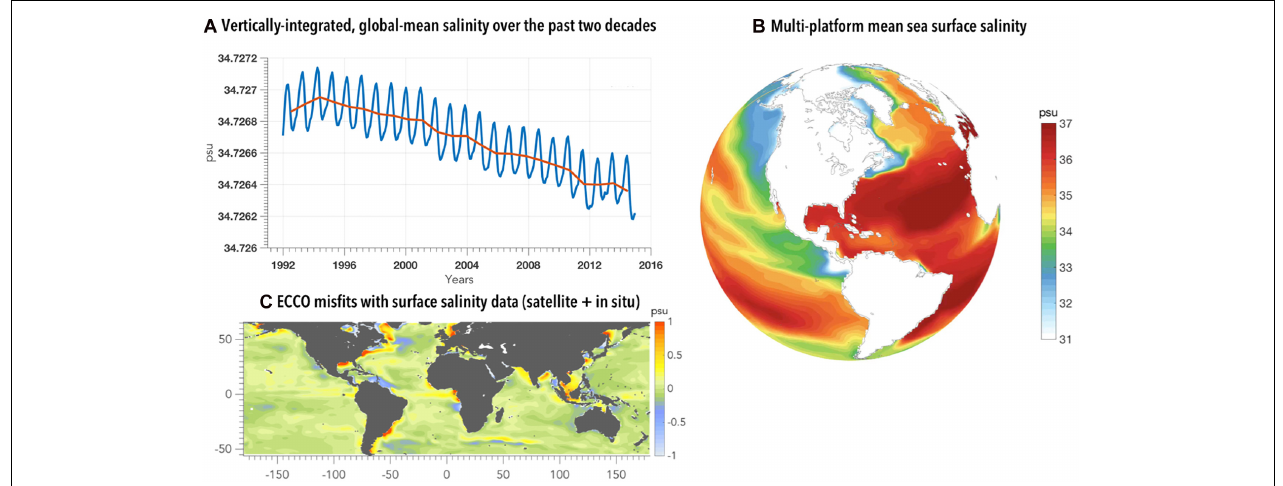
FIGURE 8 | Information from satellite SSS data improves climate models and ocean state estimates in systems like ECCO. (A) Vertically integrated, globally averaged salinity over the past two decades computed from monthly (blue) and annual (red) values. The global mean salinity value is 34.72, with a narrow range over the oceans. Notice a global freshening trend, with a drop of about –0.0005 pss/20 years, which represents the net transfer of mass into the ocean due to freshwater exchange. The value is consistent with the global-mean mass variations observed by GRACE, equivalent to –0.0004 pss/20 years. (B) Annual mean patterns in surface salinity from ECCO, featuring salty subtropics and fresher tropical and high-latitude regions, a generally saltier Atlantic and a fresher Pacific ocean. (C) ECCO/data misfits at the model surface (satellite and in situ), with distribution close to Gaussian (not shown). In most ocean regions, the misfits are less or around 0.1 of the observed averaged (green), apart from several coastal regions with higher systematic biases. Adapted from Vinogradova